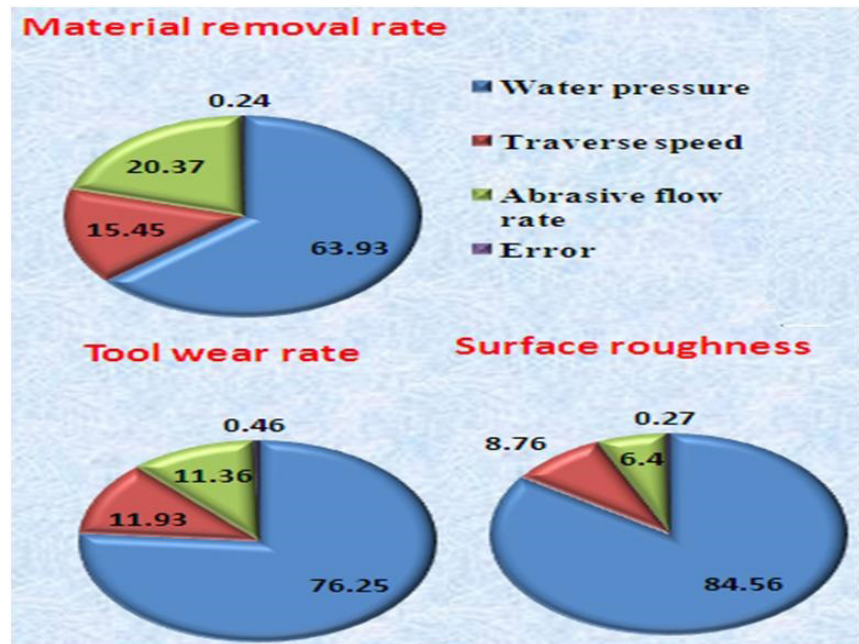
Figure 10. Percentage of contribution for each input parameter on the responses